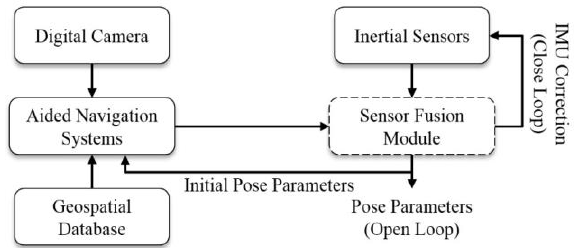
Figure 1. The proposed workflow for sensor fusion